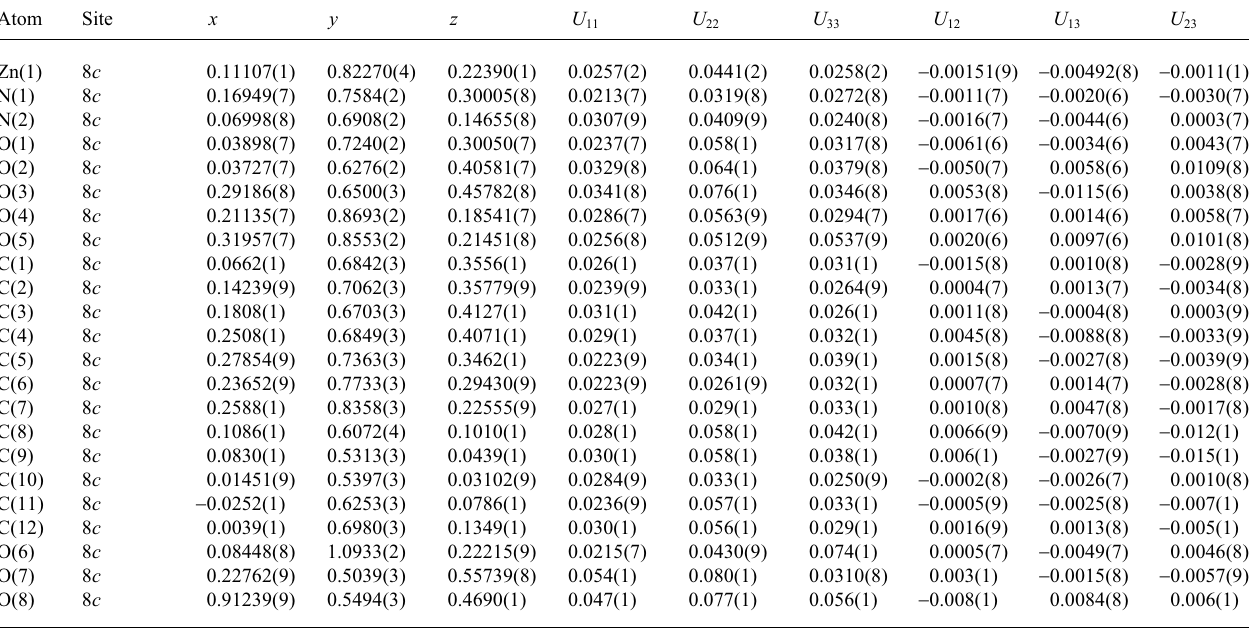
Table 3. Atomic coordinates and displacement parameters (in Å 2 )